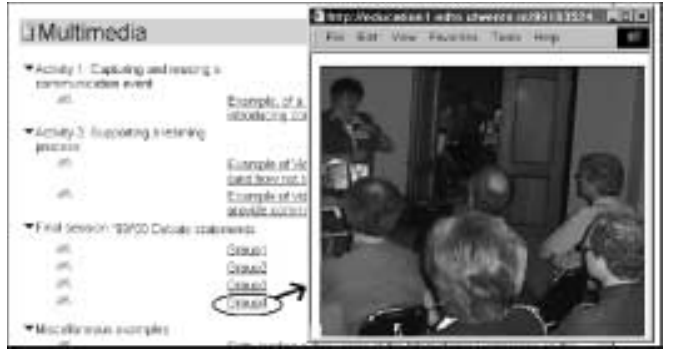
Figure 7. Example of how video captured on the fly is used as a new flexible